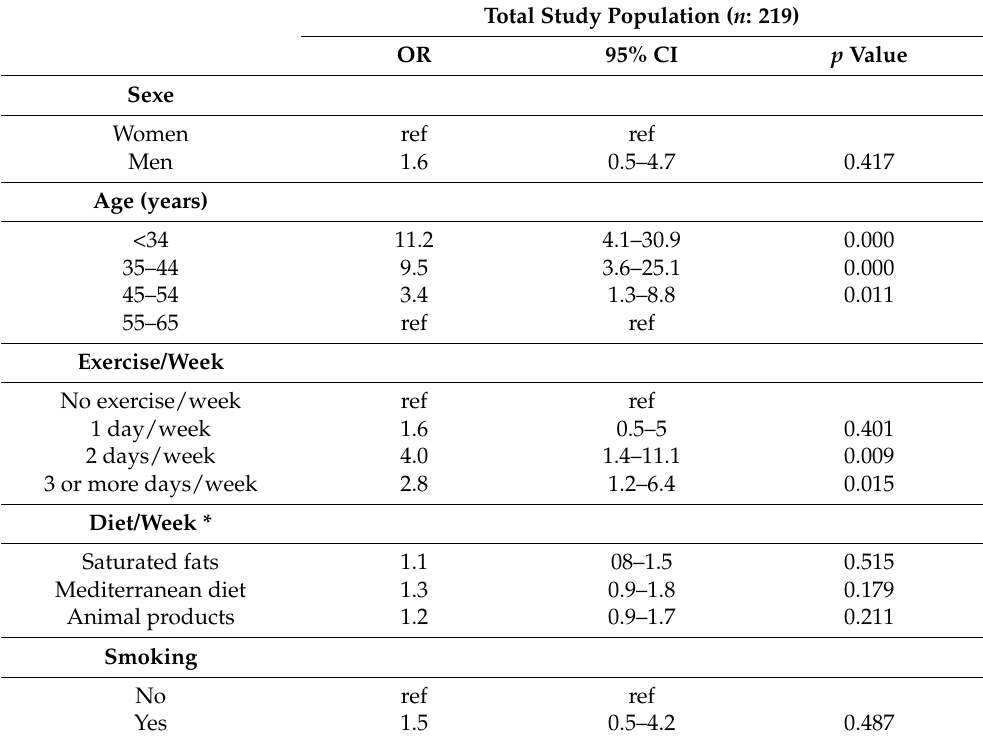
Table 4. Logistic regression considering shift work as a dependent